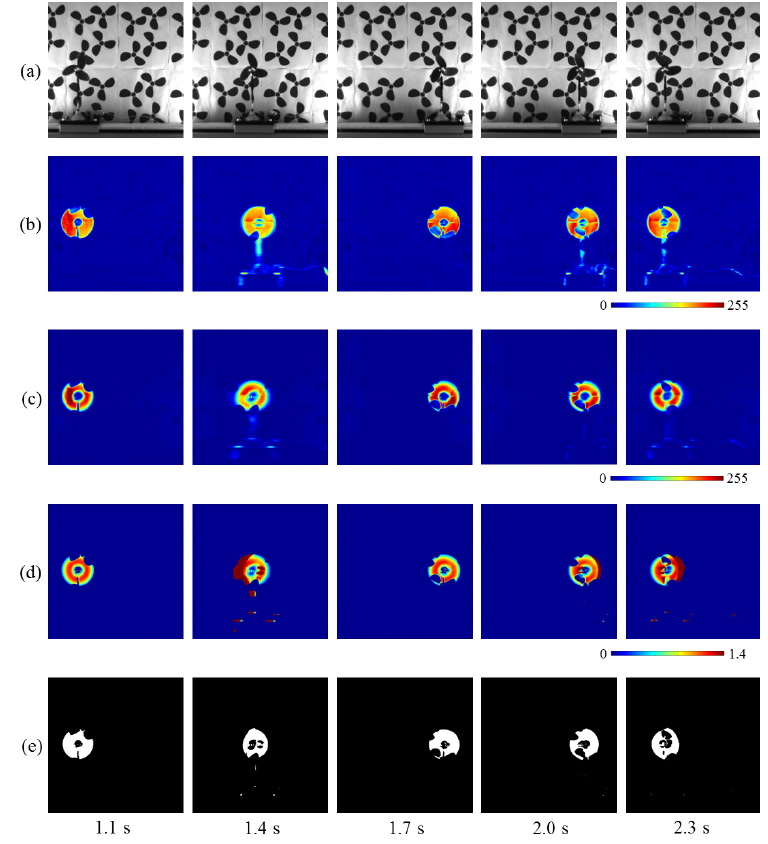
Figure 15. ( a ) Input images; amplitude of ( b ) input; and ( c ) pixel-wise filtered images; ( d ) amplitude ratios; ( e ) extracted vibration